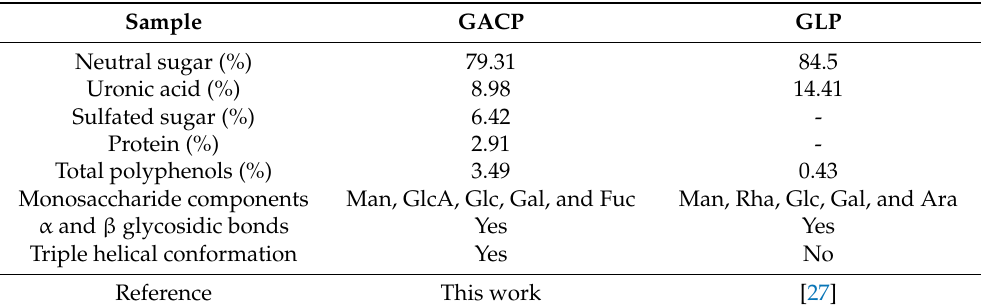
Table 5. Comparison of conformation and chemical composition of GACP and